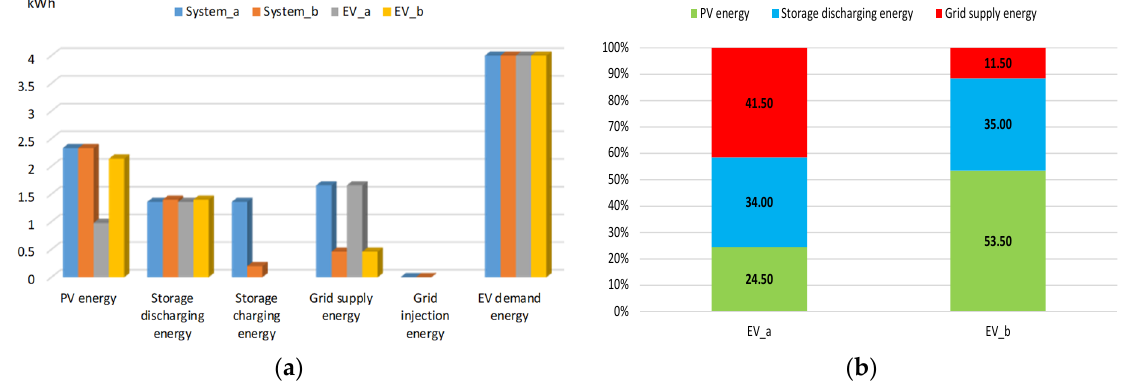
Figure 11. ( a ) Energy system distribution; ( b ) EV energy distribution for scenarios 1a and 1b.